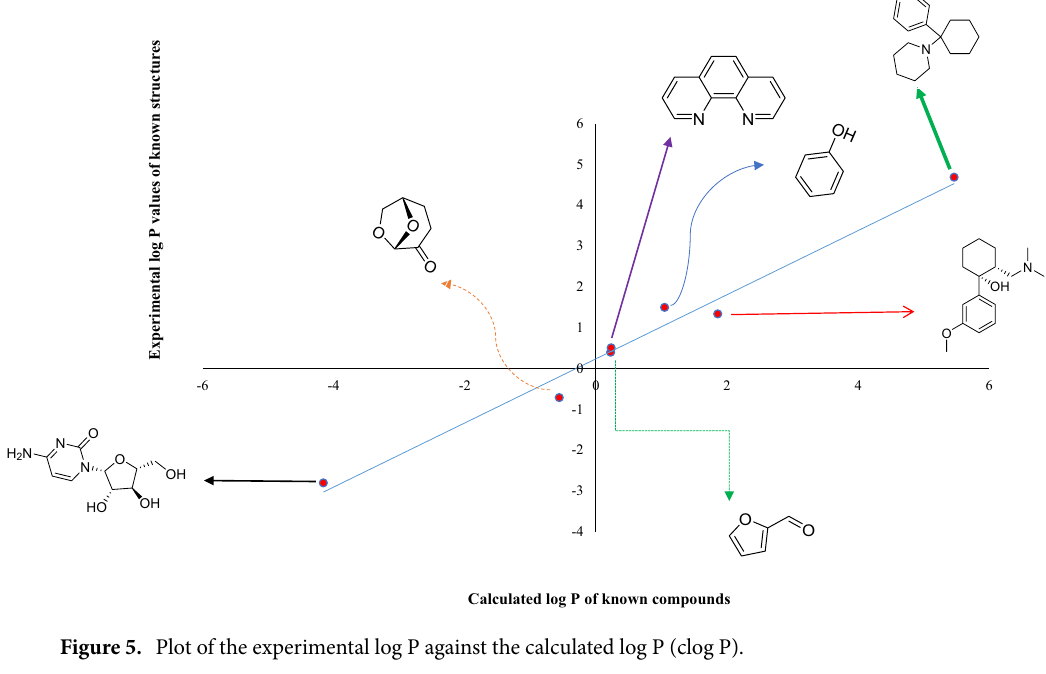
Figure 5. Plot of the experimental log P against the calculated log P (clog P).